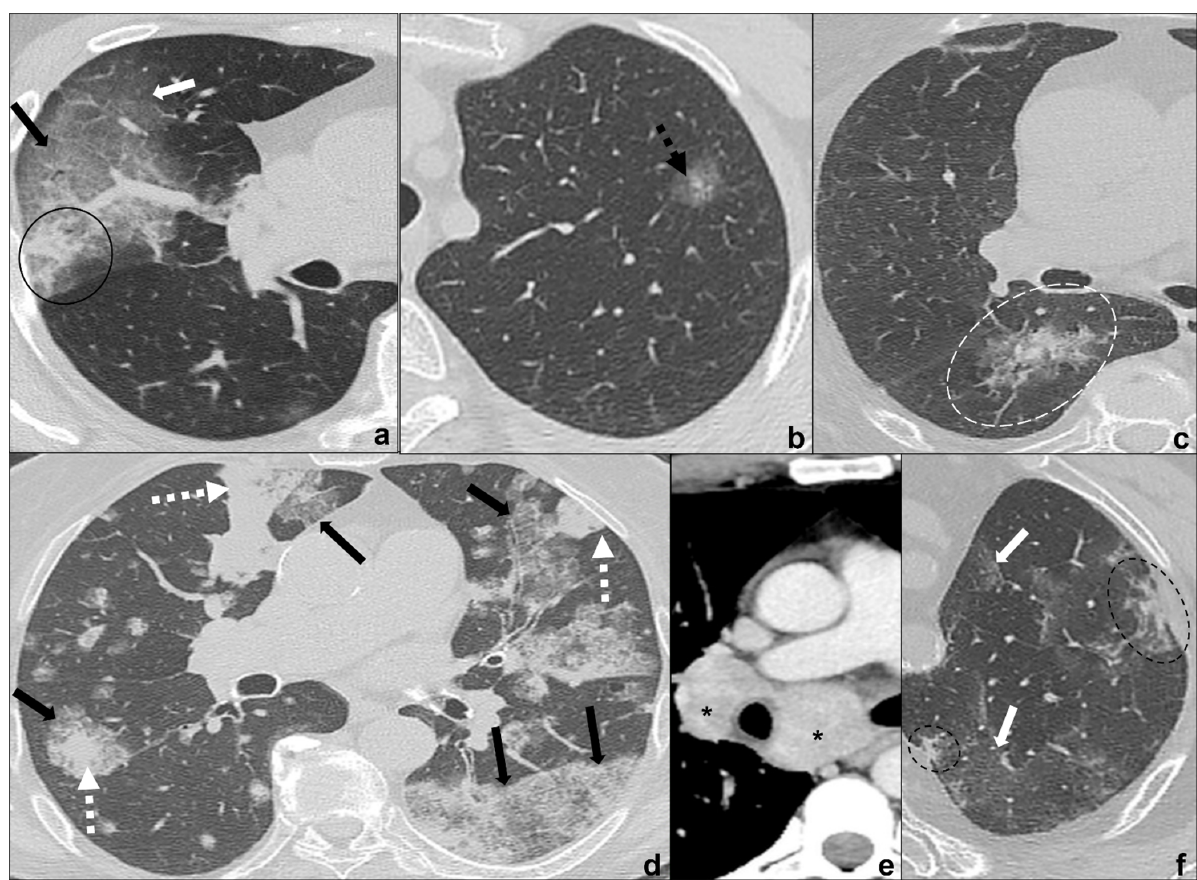
Figure 4. ( a – f ) HRTCs showing differential diagnoses of COVID-19 pneumonia stage 2–3/consolidations with ground-glass/crazy paving opacities. The transition between stage 2 and 3 of COVID-19 pneumonia is characterized by confluent consolidative foci (black circle in ( a )) in extensive areas of ground-glass (white arrow in ( a )) and/or crazy paving opacities (black arrow in ( a )). Differential diagnosis with adenocarcinoma should include: minimally invasive adenocarcinoma presenting as a ground-glass area surrounding a solid nodule < 5 mm (dotted black arrow in ( b )); invasive non-mucinous adenocarcinoma in which the nodule is >5mm and there is a small surrounding area of ground glass (dotted white circle in ( c )); and invasive mucinous carcinoma, in particular the multicentric carcinoma ( d ) which presents as bilateral intraparenchymal or subpleural consolidations (dotted white arrows in ( d )) surrounded by areas of ground-glass/crazy paving (black arrows in ( d )) co-existing with extensive areas of ground-glass and crazy paving opacities (black arrows in ( d )). Additional findings such as lymphadenopathies (black asterisks in ( e )) may guide differential diagnosis. In ( f ), HRTC of patients presenting with chemotherapy induced organizing pneumonia characterized by extensive areas of ground-glass opacities (white arrows in ( f )) coexisting with ill-defined consolidations (dotted black circle). Lungs: mean window with 1500 HU; mean window level − 600. Mediastinum: mean window with 350 HU; mean window level 50